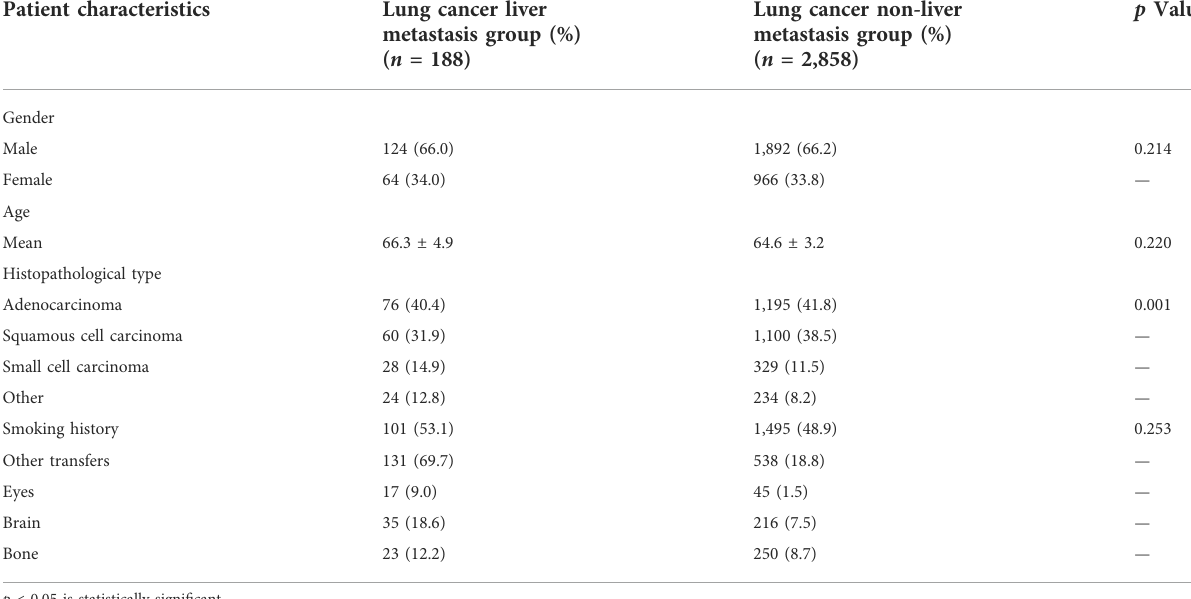
TABLE 1 Clinical data of liver metastasis of lung cancer and elderly patients with lung cancer non-liver metastases. Patient characteristics